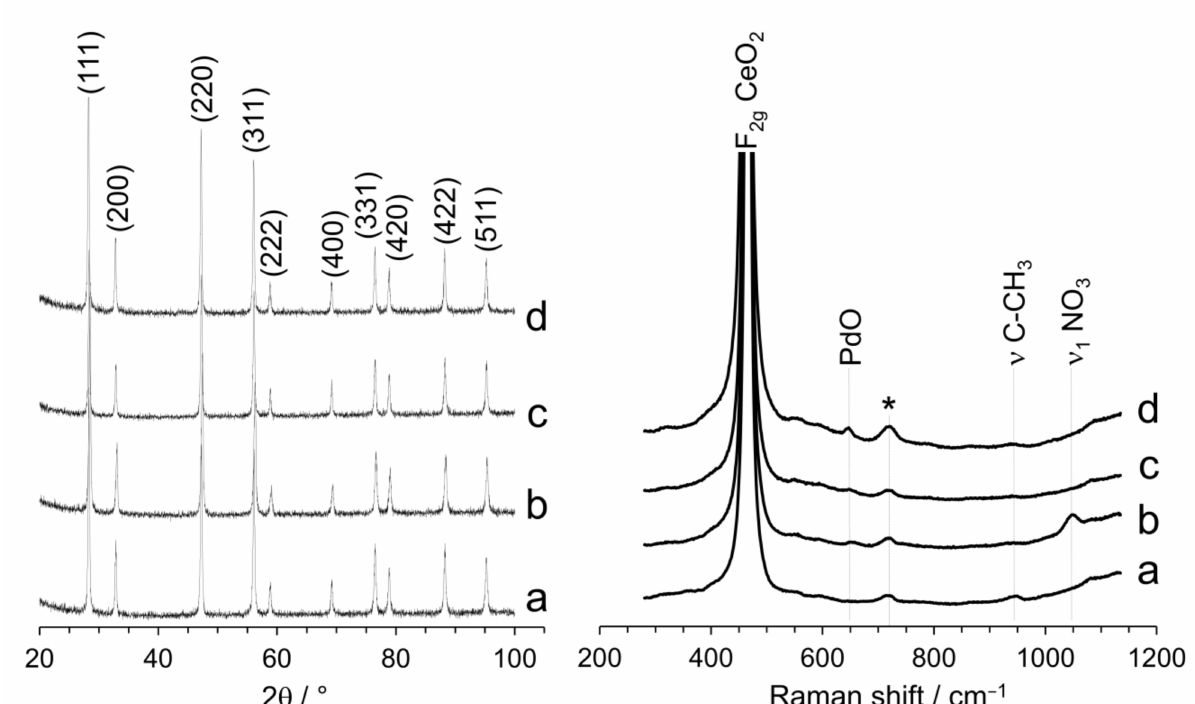
Figure 2. XRD profiles and Raman spectra of Pd/CeO 2 catalysts prepared by milling CeO 2 and Pd acetate ( a ) or Pd nitrate ( b ) at 50 Hz for 10 min, and catalysts prepared by incipient wetness impregnation with Pd acetate ( c ) or Pd nitrate ( d ). All catalysts contain a nominal Pd loading of 1